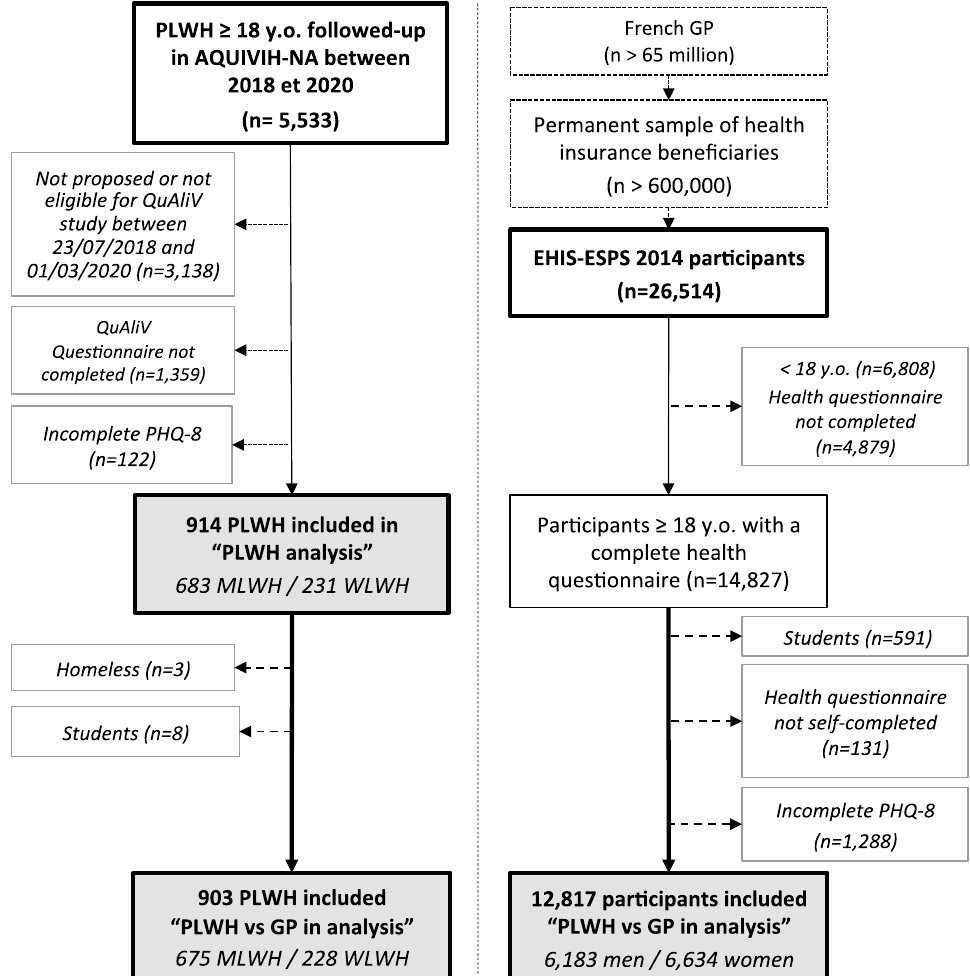
Figure 1. Flow chart of included patient in first and second analysis of QuAliV-DD study. GP general population , HIV human immunodeficiency virus , PLWH people living with HIV , PHQ8 Patient